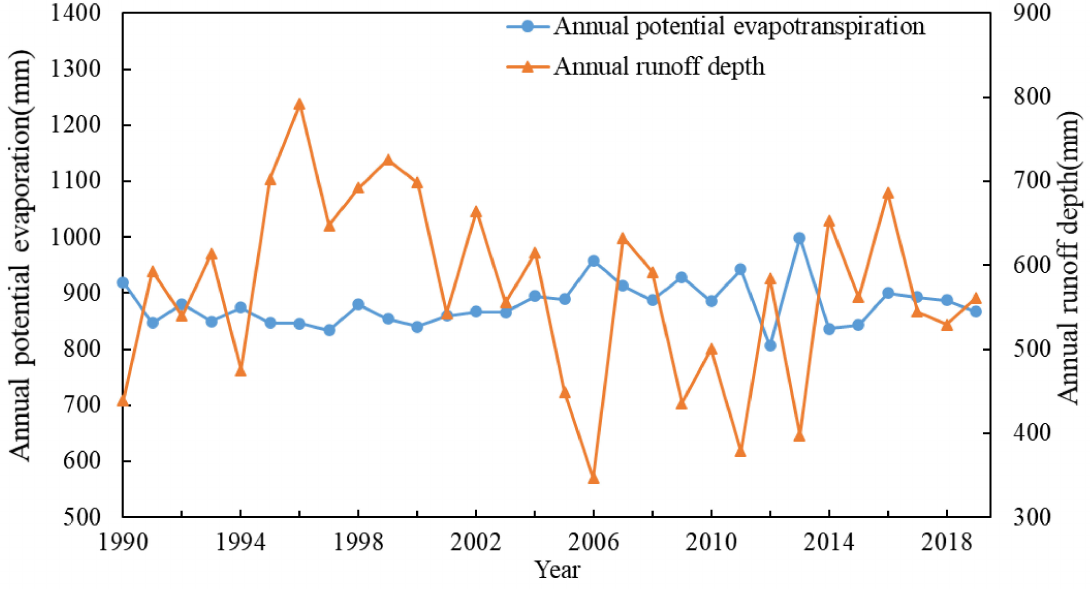
Figure 3. Potential evaporation and runoff depth inter-annual variation trends in the Wujiang River Basin from 1990 to